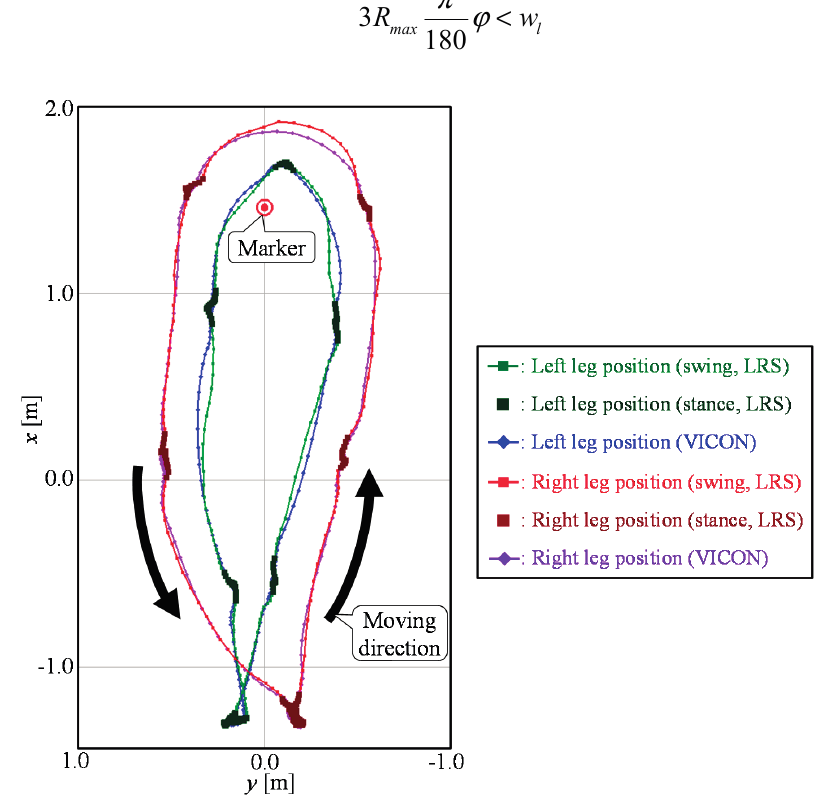
Figure 14. Example of the gait measurement results of the proposed method (Method